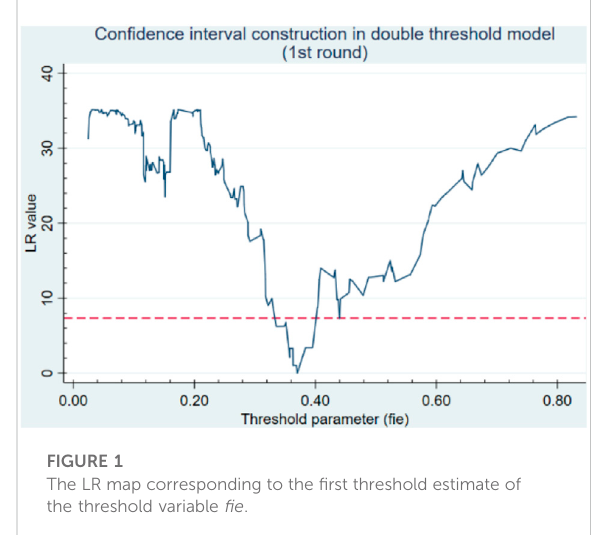
FIGURE 1 The LR map corresponding to the fi rst threshold estimate of the threshold variable fi e .